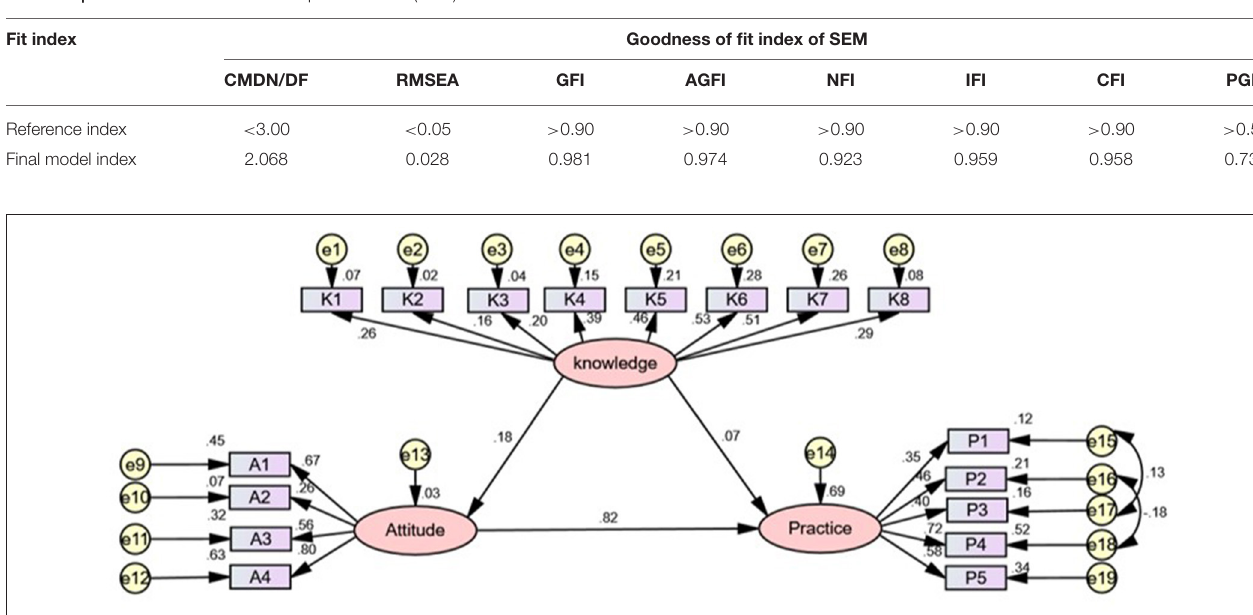
TABLE 4 | The fit indices of structural equation model (SEM).